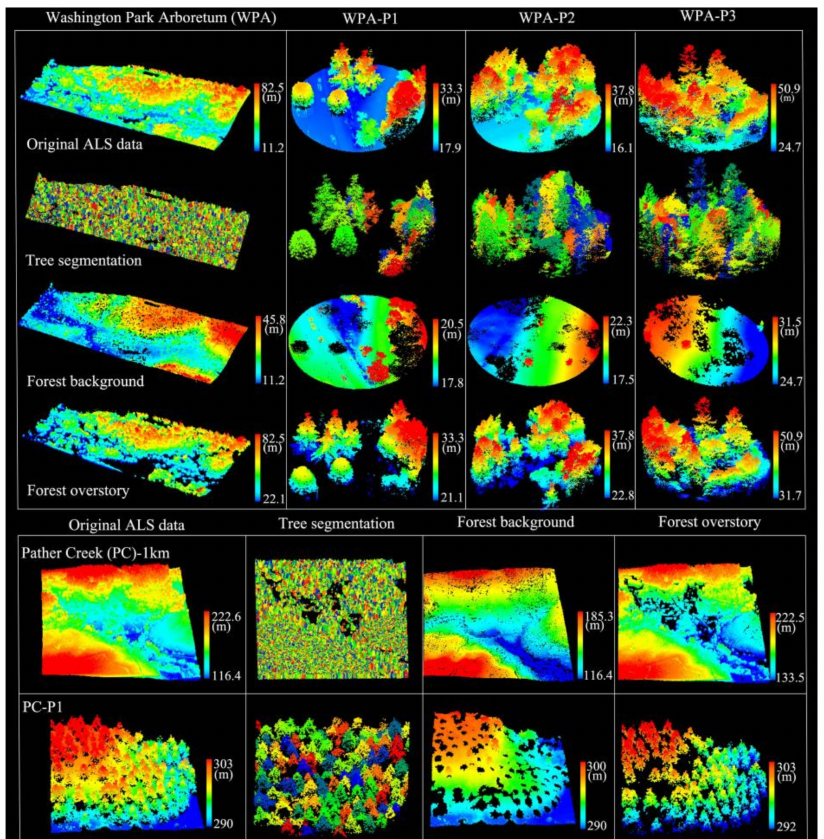
Figure 4. Graphs showing four di ff erent phases (i.e., original ALS data, tree segmentation, and stratified overstory and forest background) of vertical forest stratification in both landscape and plot. levels (WPA-P1, WPA-P2, WPA-P3, and PC-P1) in both WPA and PC sites. Table 3. Comparisons between the gap sizes obtained from stratified overstory and original ALS data and the root mean square errors of four forest component proportions between ALS and 3DSmax based in four forest plots (WPA-P1, WPA-P2, WPA-P3, and PC-P1). Plot# WPA-P1 WPA-P2 WPA-P3 PC-P1